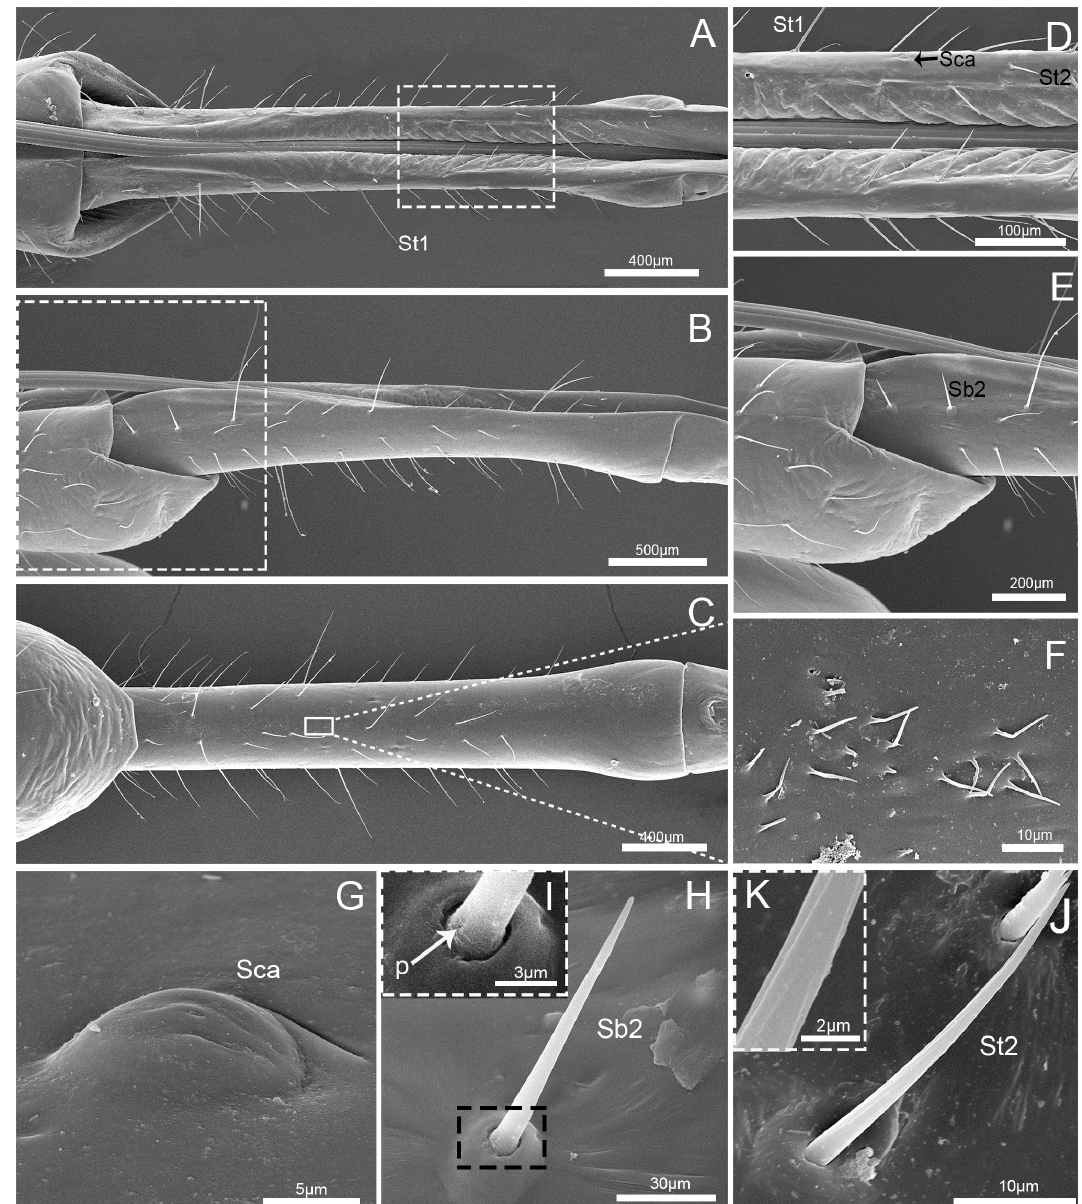
Figure 4. Scanning electron microscopy (SEM) images of the second labial segment. ( A ) Dorsal view; ( B ) lateral view; ( C ) ventral view; ( D ) enlarged view of the box in ( A ); ( E ) enlarged view of the box in ( B ); ( F ) enlarged view of the box in ( C ) showing microtrichia; ( G ) enlarged view of sensilla campaniformia (Sca); ( H ) enlarged view of sensillum basiconicum II (Sb2); ( I ) enlarged view of the box in ( H ), showing the base of sensillum basiconicum II (Sb2); ( J ) enlarged view of sensillum trichodeum II (St 2); and ( K ) enlarged view of the surface of sensillum trichodeum II (St 2). St 1, sensilla trichodea I; St 2, sensilla trichodeaII; Sca, sensilla campaniformia; Sb2, sensilla basiconica II; and p, pore.